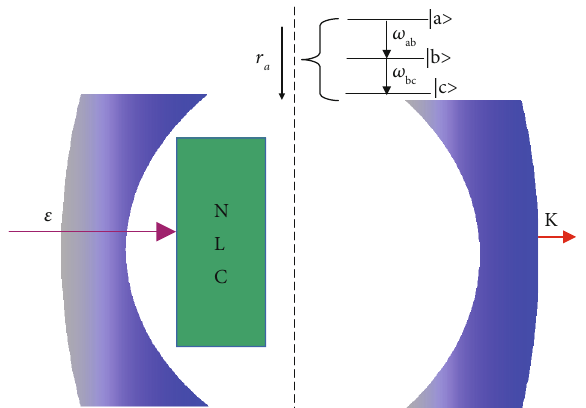
Figure 1: Schematic representation of nondegenerate three-level laser with a nonlinear crystal (NLC) and coupled to a two-mode vacuum reservoir. Here, ε , considered to be real and constant, is proportional to the amplitude of the pump mode that drives the NLC, r represents the rate at which the atoms are injected into a the cavity, and κ is cavity damping constant, and it is assumed the same for both